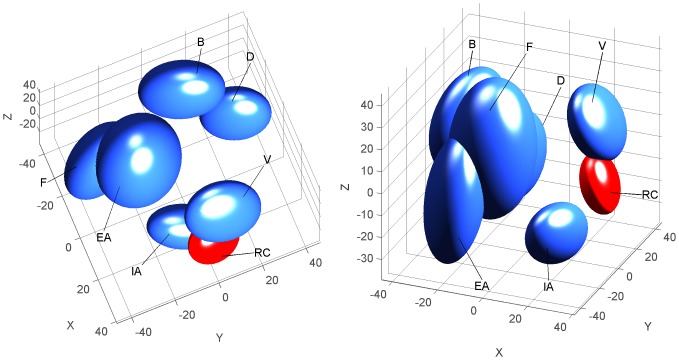
Human perception of the RC mixture.3D representation (2 different views) of the sensory map obtained from the free sorting task FS1 based on the sorting of the RC mixture and of its components (EA, D, V, IA, B, F) by human adults. The map was drawn using a non-metric MDS analysis. Ellipsoids represent 95% confidence intervals and were calculated using a bootstrap algorithm.